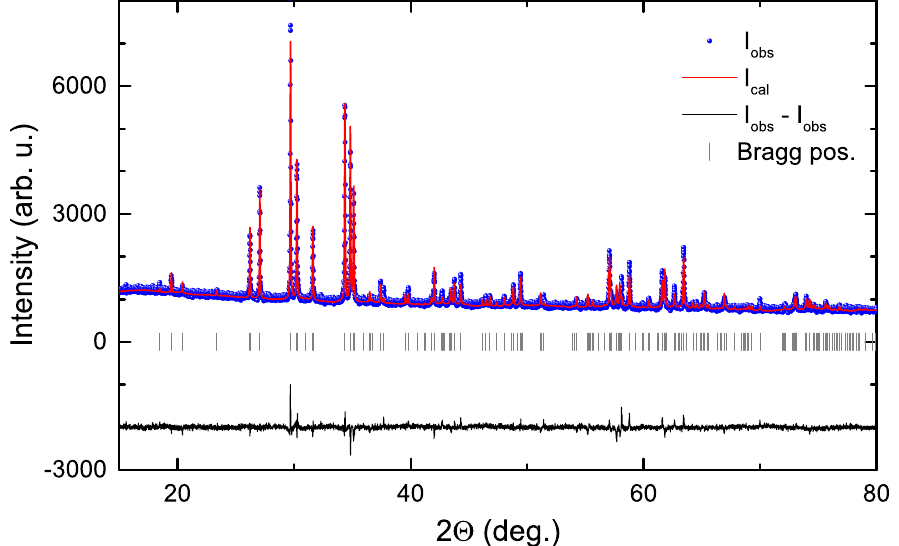
Figure 3. Powder X-ray diffraction pattern of a crushed CoGeO 3 single crystal. The magnetic susceptibility χ of CoGeO 3 shows a drop at T N ∼ 33.5 K, see Figure 5. The transition to an antiferromagnetic state is in agreement with literature [8]. The avail- ability of sizeable single crystals allowed us to measure also the direction dependence of the magnetic susceptibility. These direction dependent measurements (with H || c and H ⊥ c ) reveal a highly anisotropic behavior of χ . The Weiss temperatures Θ W obtained from Curie–Weiss fits even have different signs for H || c and H ⊥ c and amount to 45.08 K and − 49.55 K, respectively. This strong anisotropy arises from the presence of single ion anisotropy in the system which is typical for Co 2 + -ions [11,14]. Moreover, the correspond- ing effective moments µ eff amount to 4.76 µ B and 5.18 µ B respectively. The value of the effective moments in CoGeO 3 is much larger than the theoretical spin-only value for Co 2 + ions of 3.87 µ B and suggests that the Co 2 + ions are in a high spin state with large orbital moment contributions. For powder samples, the Weiss temperatures Θ W amount to 6.46 K with effective moments µ eff of 4.98 µ B